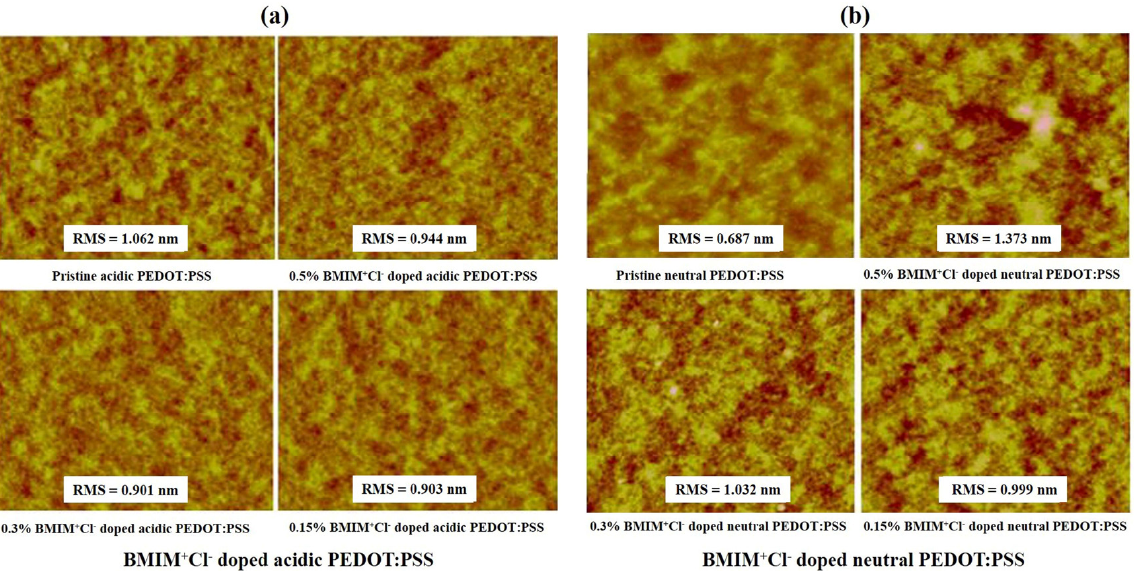
Figure 6. Surface morphology characterization, tapping mode AFM images of BMIM + Cl − -doped ( a ) acidic PEDOT:PSS and ( b ) neutral PEDOT:PSS at different concentrations of ionic liquid (the size of the scanned area was 2 × 2 µm).